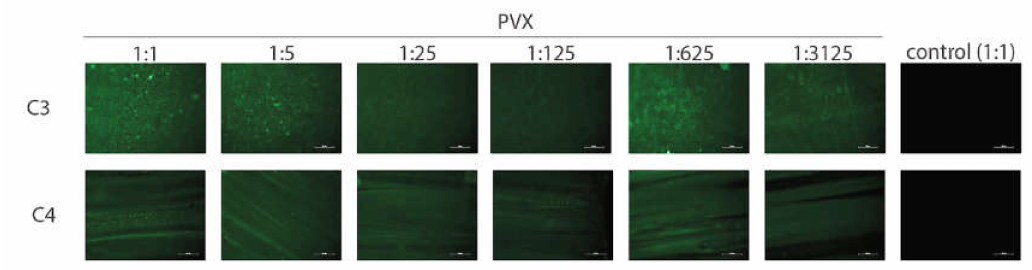
Figure 6. Detection of potato virus X (PVX) on C3 and C4 scaffolds using immunofluorescence. The tested dilutions of infected plant lysate are indicated above the figure (control = non-infected lysate). Color corresponds to presence of PVX C and reflects binding to scaffold. Bar = 50 µ